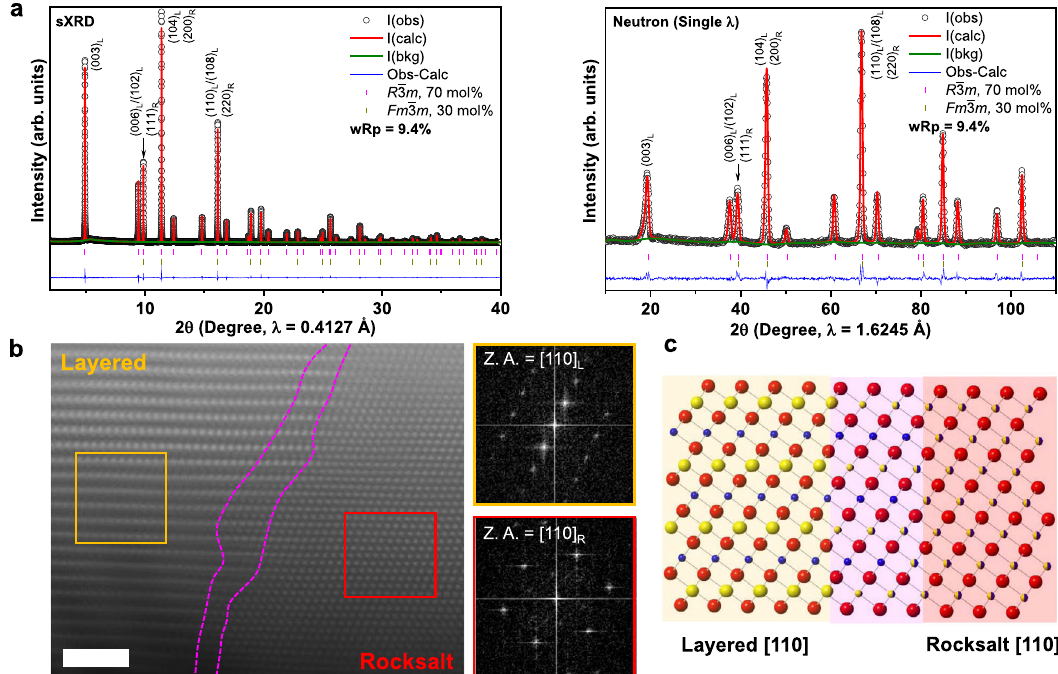
Fig. 1 Li 1.2 Ni 0.4 Ru 0.4 O 2 of layered-rocksalt intergrown structure. a sXRD and ND patterns with Rietveld fi ts for Li 1.2 Ni 0.4 Ru 0.4 O 2 ; re fi nement is performed based on R (cid:1) 3 m and Fm (cid:1) 3 m biphasic model, indicating 70 mol% R (cid:1) 3 m ( a = 2.94194(7) Å, c = 14.40729(2) Å, and V = 107.990(1)Å 3 ) and 30 mol% Fm (cid:1) 3 m ( a = 4.15874(6)Å and V = 71.926(1) Å 3 ); critical re fl ections are indexed as (hkl) L and (hkl) R for R (cid:1) 3 m and Fm (cid:1) 3 m , respectively. b Representative HAADF- STEM image and FFT of the selected areas highlighted by orange and red box, respectively, showing the layered-rocksalt intergrown structure along the [110] zone axis. Scale bar is 2 nm. c Schematic of layered-rocksalt intergrown structure along the [110] zone axis, pink highlight showing the structurally compatible region with different TM arrangements in the Li and TM slabs.